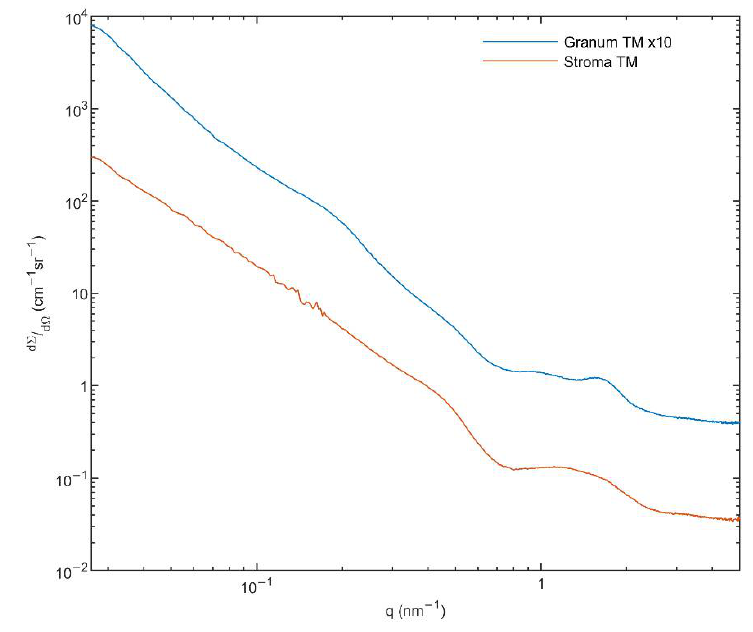
Figure 4. Small angle X-ray scattering (SAXS) of granum (blue) and stroma (red) TMs. Monochroma- tized and collimated Cu K α radiation, with a 0.1542 nm wavelength was used. Scattering pattern was recorded in the range of 0.02–5 nm − 1 . Total measurement time was 12 h for each sample at three geometries. For an easier comparison, the SAXS signal of granum TMs was multiplied by a factor of 10. (For further details, see Methods.).